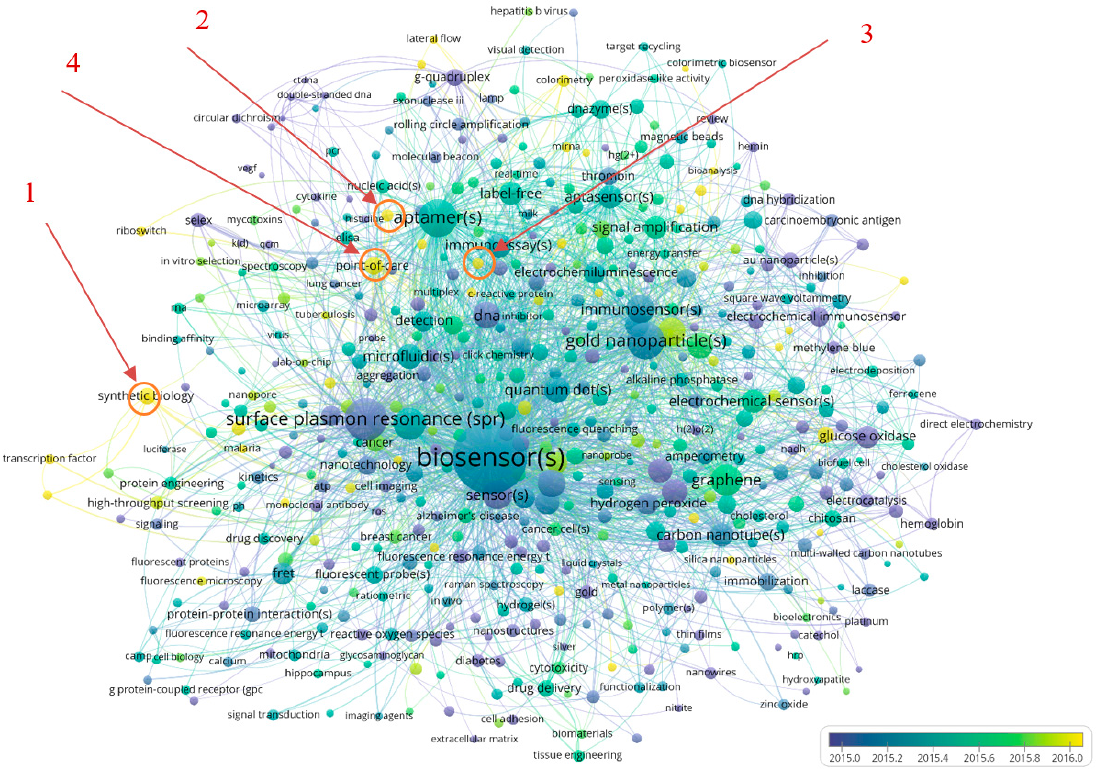
Figure 23. Co-occurrence analysis of Other Terms (or Author Keywords) with time overlay. Table 10. Recent author keywords based on average publication years and the number of occurrences.